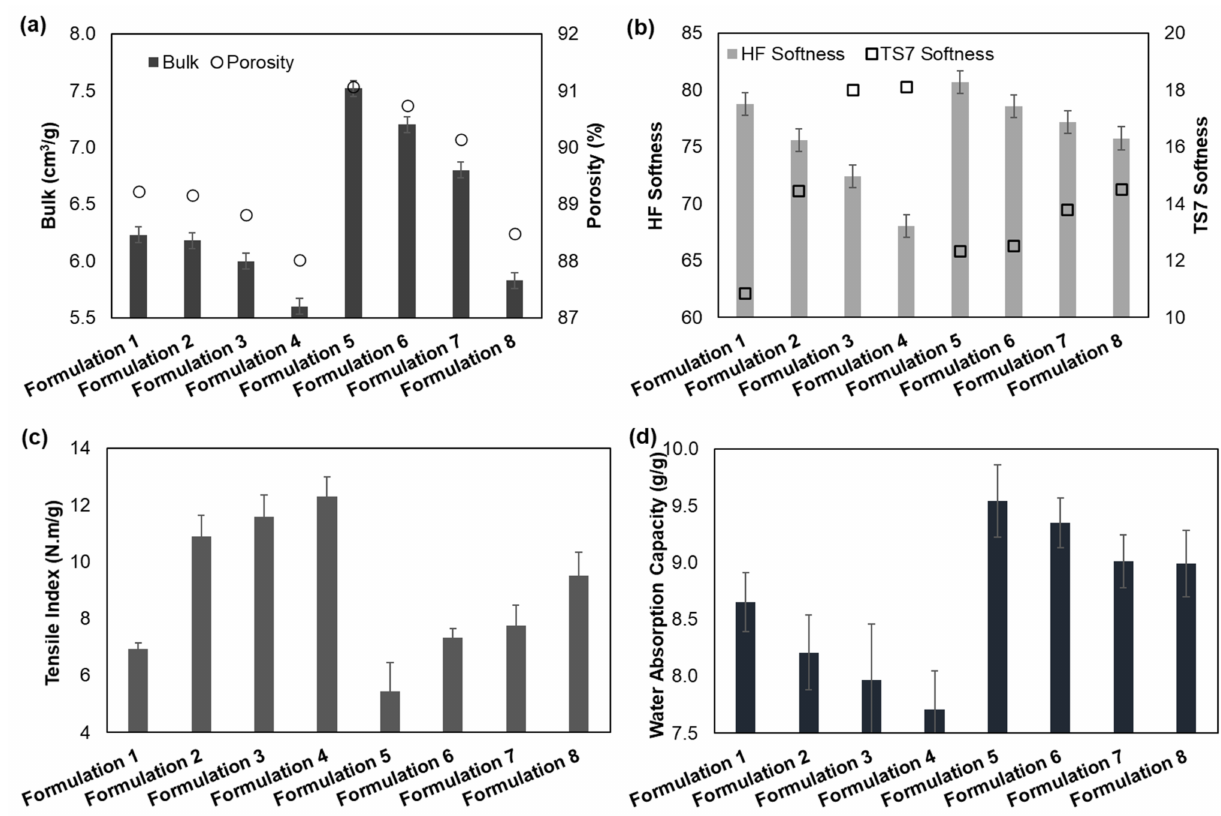
Figure 6. Properties of bulk and porosity ( a ), softness ( b ), tensile index ( c ) and water absorption capacity per unit of gram ( d ) of all tissue formulations.